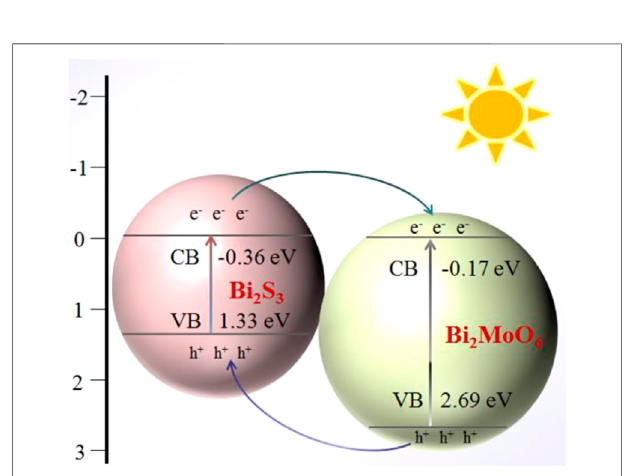
FIGURE 4 | EIS (A) and photocurrent intensity (B) of bare ITO, Bi 2 MoO 6 /ITO, and Bi 2 MoO 6 /ITO after reacting with L-Cys.